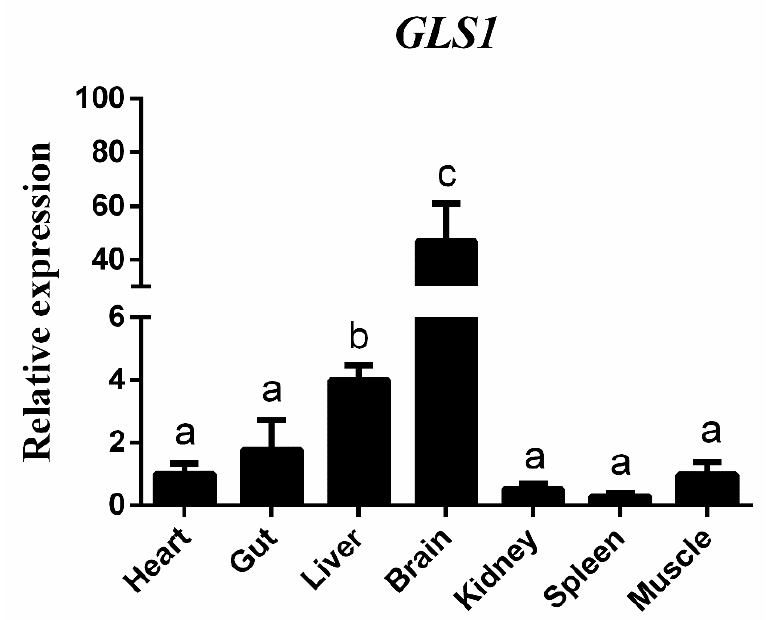
Figure 3. The relative expression of TCC gls1 in the heart, gut, liver, brain, kidney, spleen, and muscle. Different letters represent significant difference ( p < 0.05, n = 9 for each bar).